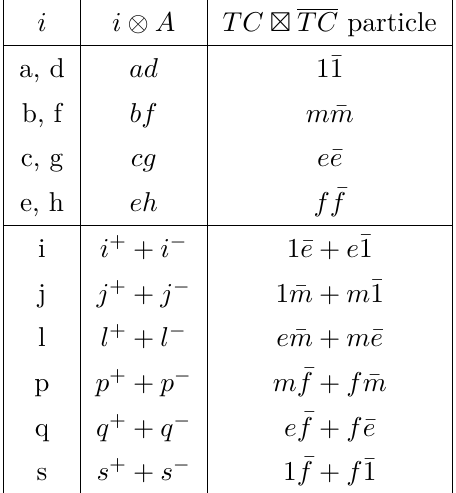
Table 9 . Identify child theory of A = a + d condensation with TC (cid:2) TC .